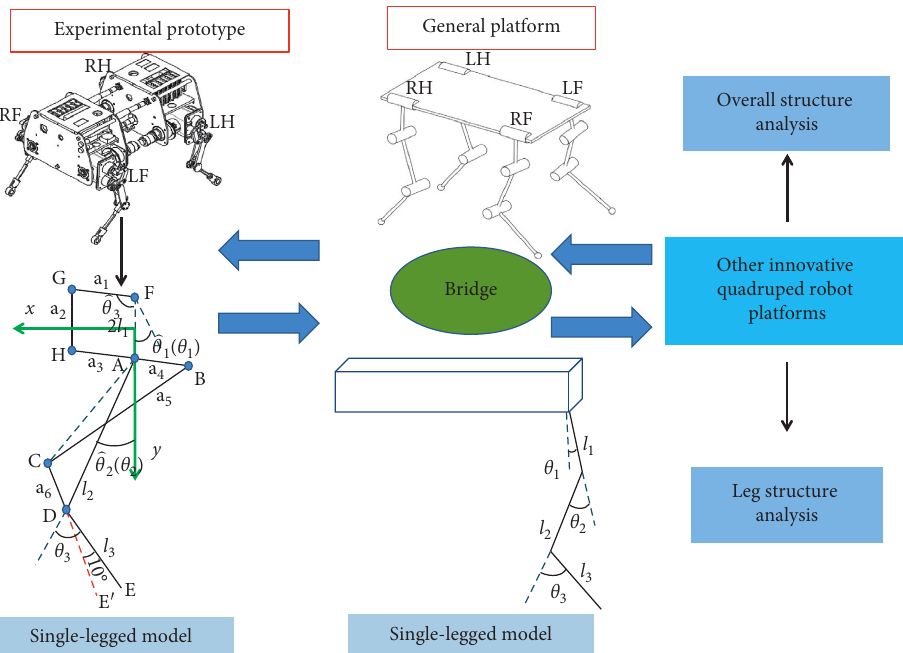
Figure 6: Simplification and transformation between the single-leg structure of the prototype and the general platform. Table 2: Properties of the prototype leg.